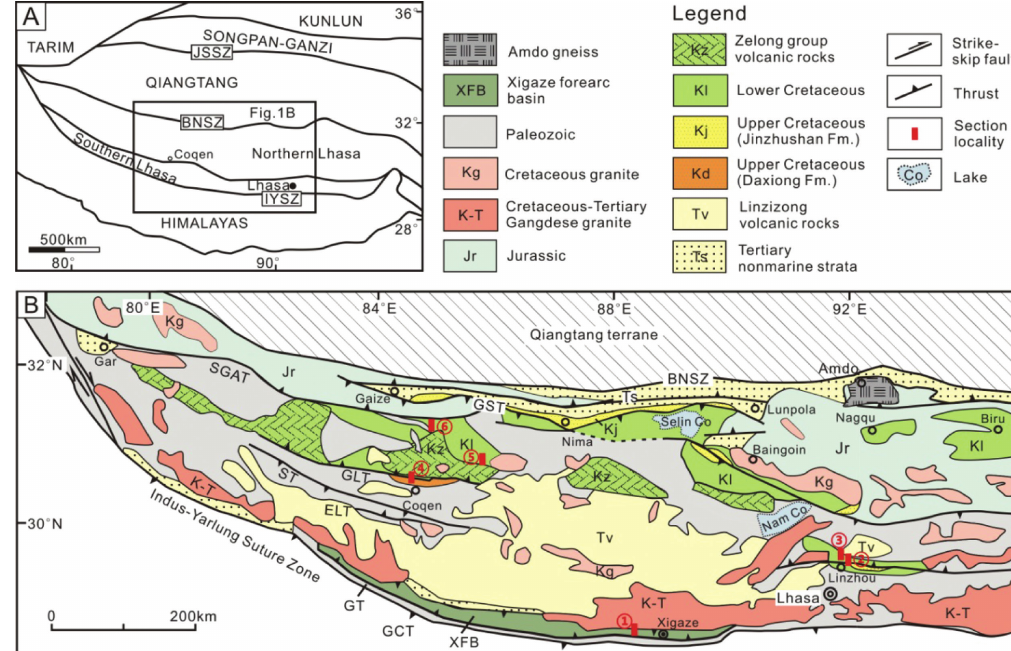
American province became extinct at the end of PZ Albian 2 (106.7 Ma). All forms in the sub- (A) Simplified tectonic map of the Tibetan Plateau and adjacent regions, province that is today South East Asia (on the margins and to the west of the Wallace Line) went showing the Lhasa terrane in the extinct at the end of the Albian (top of PZ Albian 4). The ‘hotspot’ for orbitolinid evolution, context of the Tibetan Plateau [58]. however, remained in Tethys, where environmental conditions continued to contribute to their JSSZ, Jinsha suture zone; BNSZ, Bangong-Nujiang suture zone; success until the end of the Cenomanian, when virtually all symbiotic, morphologically complex IYSZ, Indus-Yarlung suture zone. (B) orbitolinids became extinct, as indeed did many of the other agglutinated LBFs that dated from the Simplified geological map of the Lhasa Early Cretaceous and Jurassic (see [1]). These extinctions coincided with an anoxic oceanic terrane modified from [59]. SGAT, Shiquan-Gaize-Amdo thrust; GST, Gaize–Selin Co thrust; GLT, Gugu La thrust; ST, Shibaluo thrust; ELT, Emei La thrust; GT, Gangdese thrust system; GCT, Great Counter thrust. Section 1 from the Xigaze forearc basin; Sections 2 and 3 from the Linzhou basin; Sections 4, 5 and 6 from the Coqen basin.